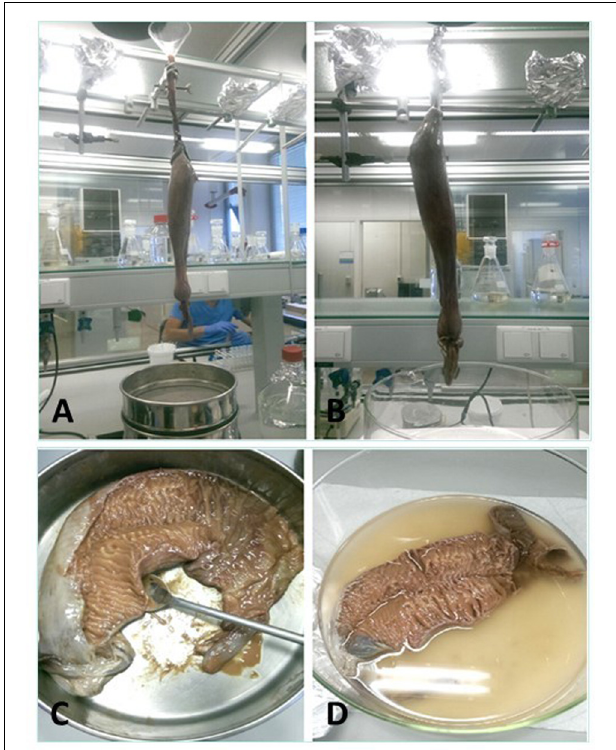
FIGURE 3 | The four different methods for the content collection. (A) Spiral valve hung above sieves and held open with a glass funnel to wash out contents, (B) spiral valve hung above glass bowl, ready for massaging, (C) opened spiral valve in a metal bowl to scrape out the content, (D) opened spiral valve in glass bowl filled with milliQ water to wash out